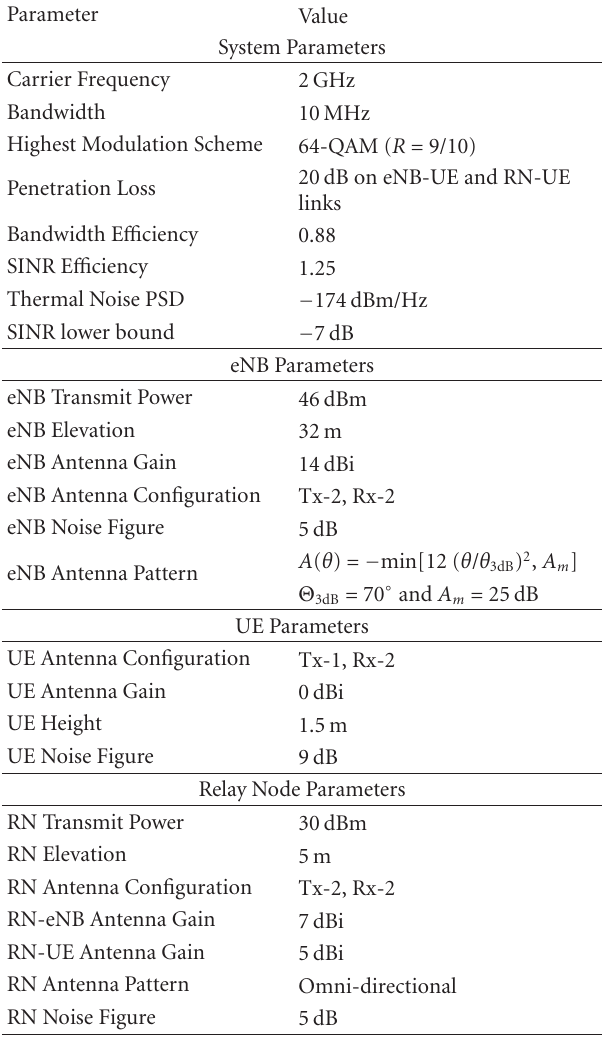
Table 2: Simulation